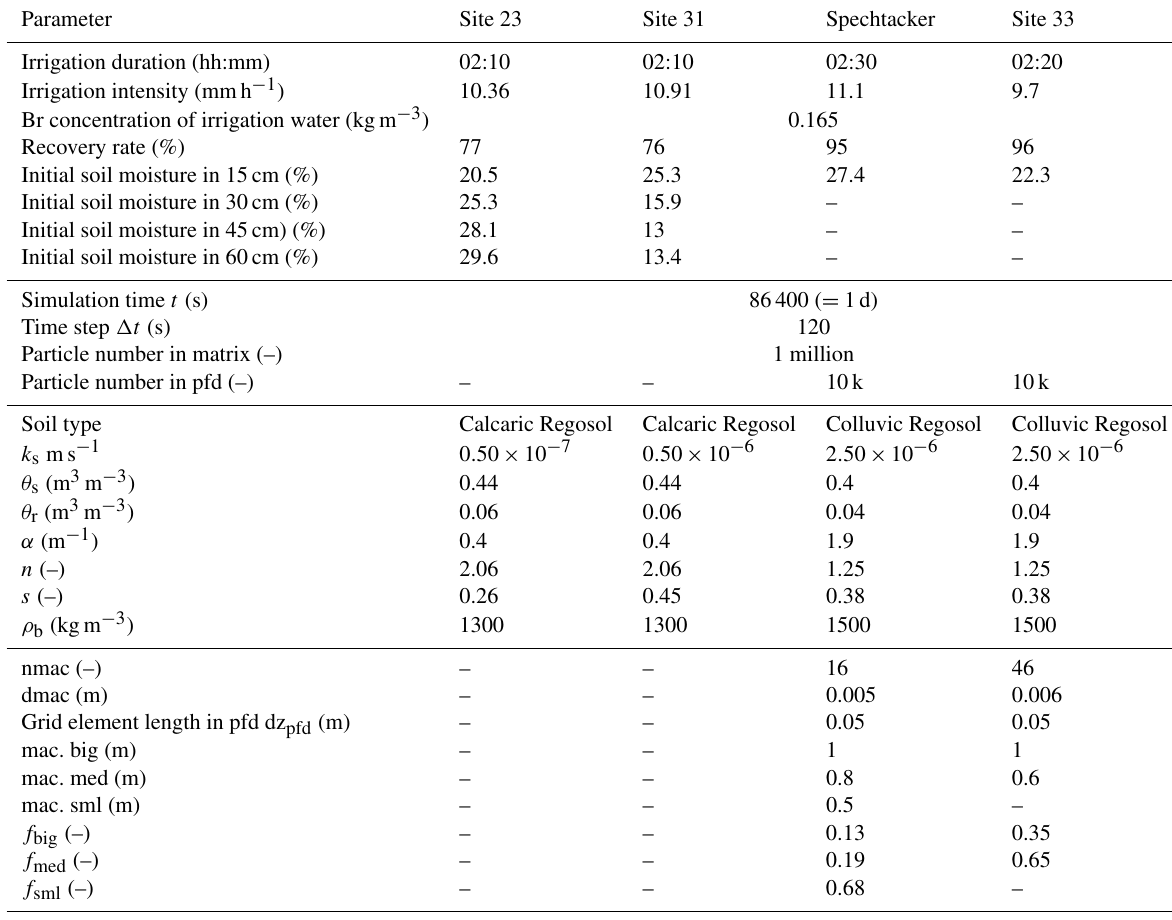
Table 1. Simulation and tracer experiment parameters (average values) as well as soil hydraulic parameters following Schäfer (1999) at sites 23, 31, Spechtacker and 33, where k s is the saturated hydraulic conductivity of the matrix, θ s the saturated soil water content, θ r the residual soil water content, α the inverse of an air entry value, n a quantity characterizing pore size distribution, s the storage coefficient and ρ b the bulk density. In general, all these observable parameters can be freely adjusted in our model and are hence independent of other variables. All other calculated parameters presented in the text are dependent on these observable parameters.